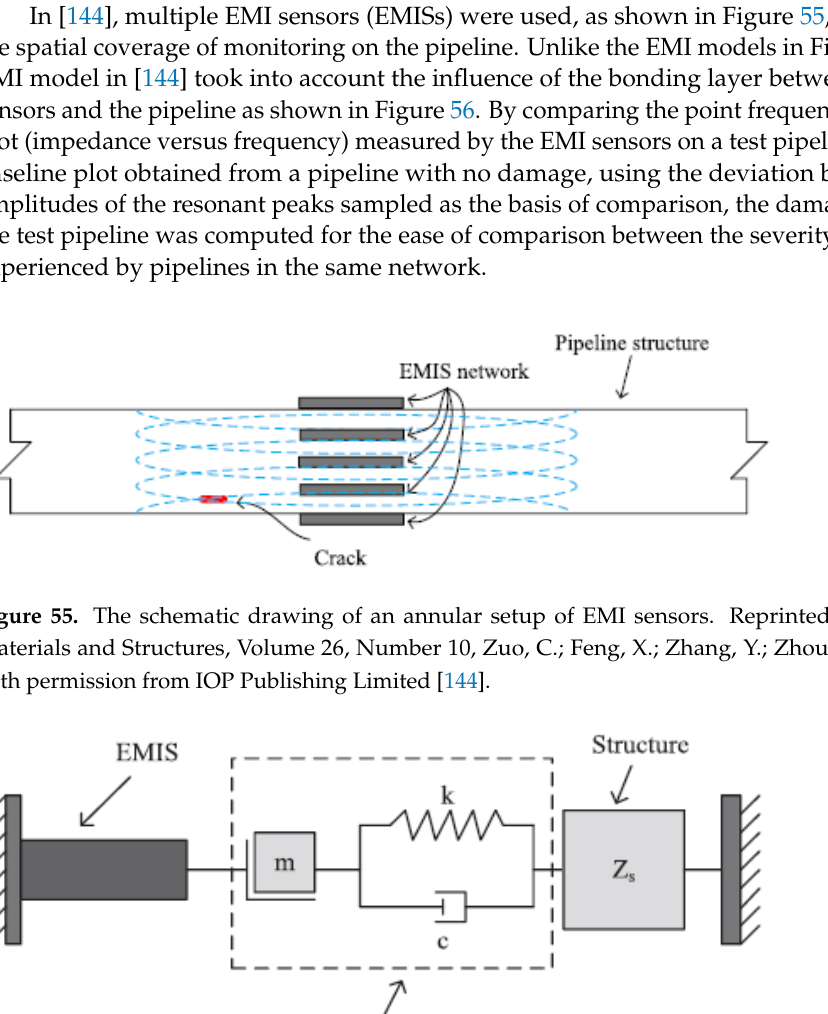
Figure 54. ( a ) EMI measurement setup using one piezoelectric transducer (PZT). ( b ) EMI measure- ment setup using two piezoelectric transducer (PZTs). Reprinted under Creative Commons CC BY license [143].